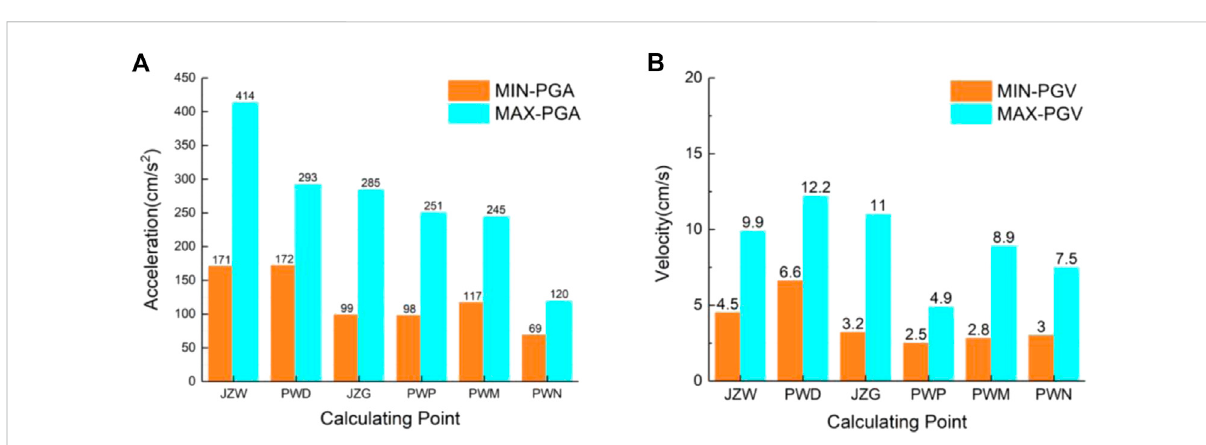
FIGURE 8 Value range of the PGA and PGV obtained from the intersection of the three types of attenuation relationships.